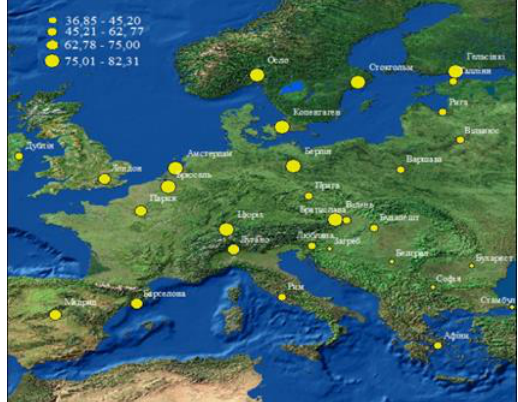
Figure 3. Estimation of efficiency of metabolic processes of cities in Europe (Acebillo, J., et al., 2012) For example, the reduction on 0.1 kg/inh∙y of solid household waste generated by population in a dense urban development of provides an increase of urban environmental efficiency by 5%, while a decrease in the amount of energy consumed for the heating of buildings and structures by 10 kWh/m2 provides an increase in the efficiency of the urban environment by 8- 10%. In fig. 8 shows the surface of efficiency, depending on the amount of energy consumed for the heating of buildings and produced solid household waste, which can be interpreted as a kind of landscape of the urban environment of the cadastral zone 10 of